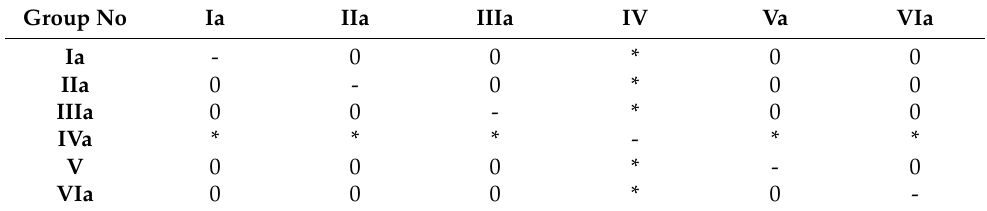
Table A5. The membrane thickness of capillary tuft in rats fed with high cholesterol diet. Statistical differences between all experimental groups; * significant, 0 insignificant.